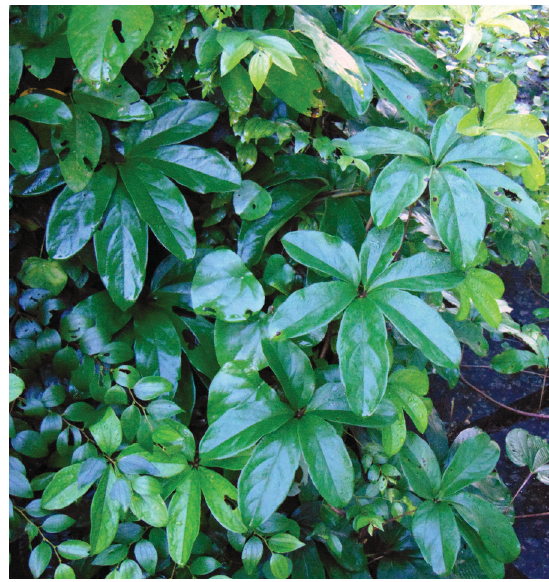
FIGURE 2 - Vegetative parts of D. pentaphylla